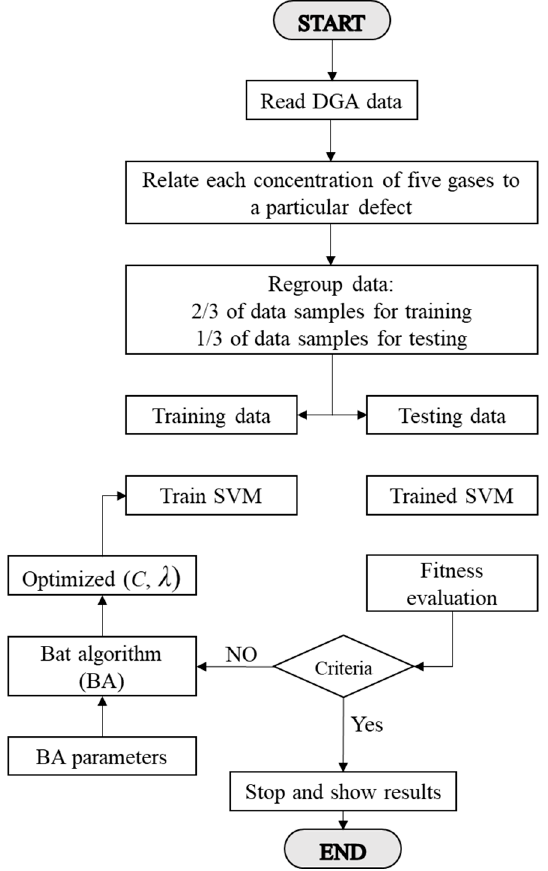
Figure 4. Flowchart formulating SVM-BA Classifier. Table 2. Parameters of Bat